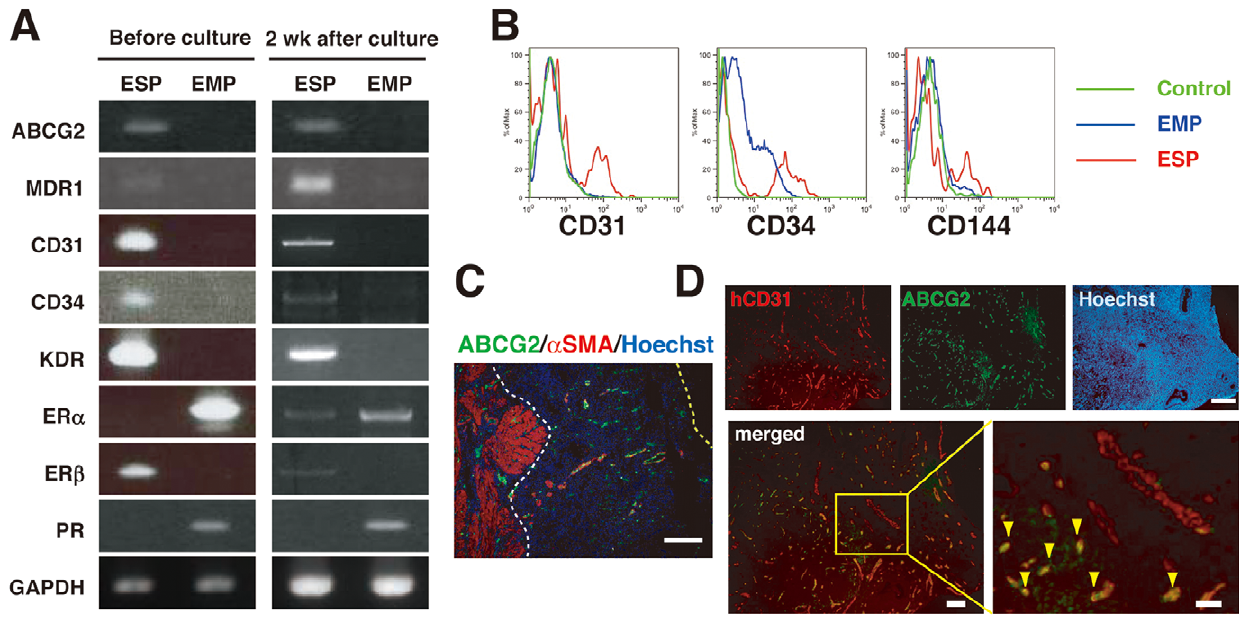
Figure 4. Subpopulations of ESP cells: surface markers, and localization in human endometrium. ( A ) RT-PCR analyses of various transcripts in ESP and EMP cells before and after two weeks of culture. MDR1, multidrug resistance 1; KDR, kinase insert domain-containing receptor. ( B ) Flow cytometric analysis of ESP and EMP cells immunostained with isotypic control antibodies or antibodies against endothelial cell surface markers (CD31, CD34, and CD144). ( C ) An immunofluorescence merged image of human endometrium co-stained with Hoechst and antibodies against ABCG2 and a SMA. White and yellow dotted lines indicate the endometrium-myometrium junction and the luminal surface of the uterine epithelium, respectively. Bars, 200 m m. ( D ) Immunofluorescence images of human endometrium co-stained with Hoechst and antibodies against hCD31 and ABCG2. A small box marks a region shown at a higher magnification in the adjacent panel as indicated. Yellow arrowheads indicate endothelial cells doubly positive for hCD31 and ABCG2. Bars, 200 m m (upper), 100 m m (lower left) and 50 m m (lower right).